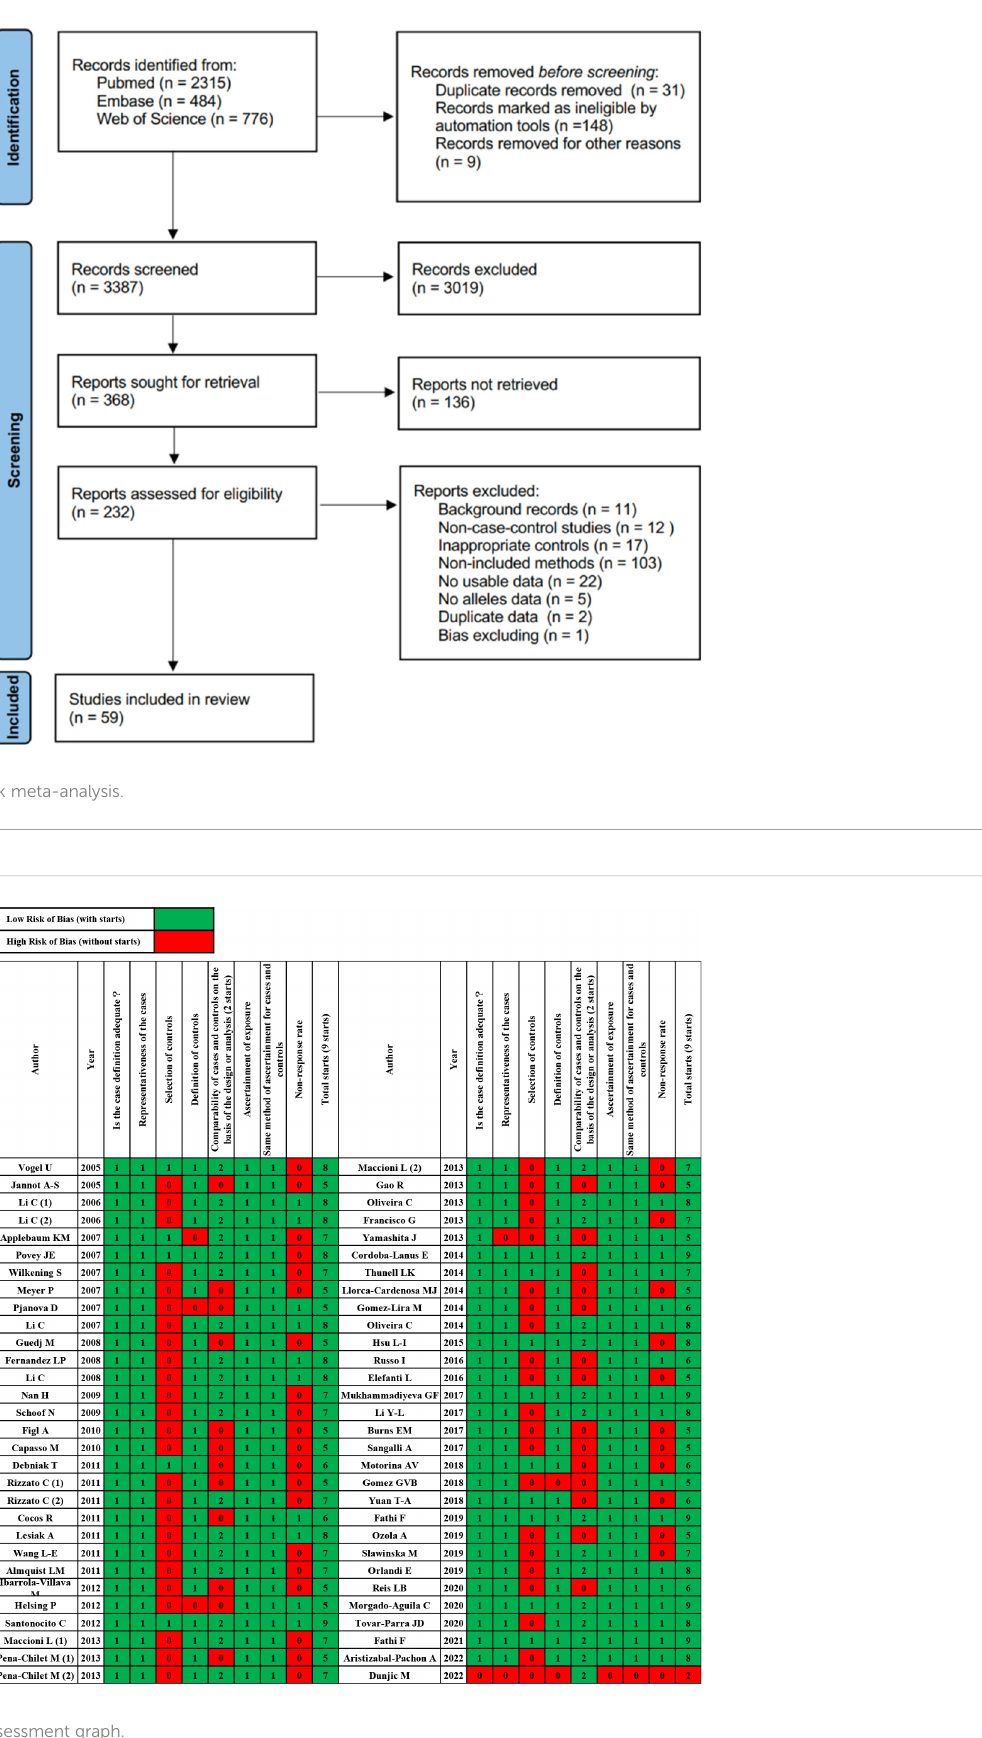
FIGURE 2 Case – control risks of the bias assessment